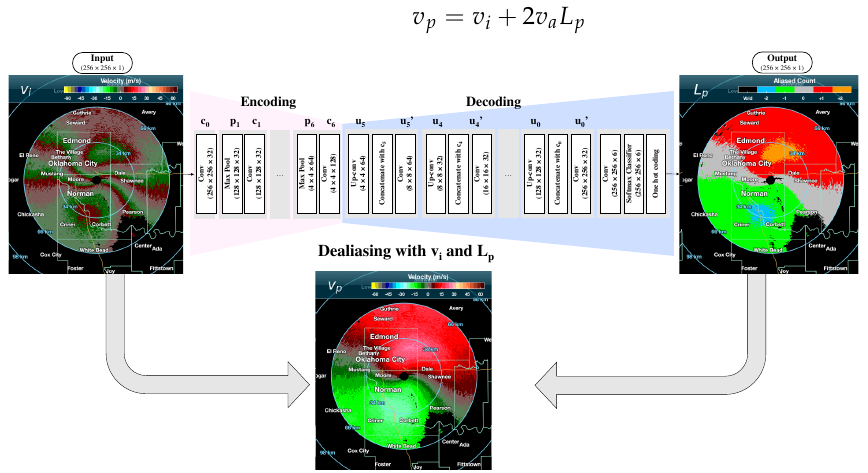
Figure 2. Block diagram of the proposed velocity dealiasing technique using a CNN. Velocity dealiasing is performed by combining the input (aliased) velocity ( v i ) and the aliasing count ( L p ). v i passes through the model, which consists of multiple layers of operations, i.e., convolution, pooling, softmax, and prediction. To that end, the technique produces a map that indicates whether a velocity measurement is aliased, the sign, and how many times it is